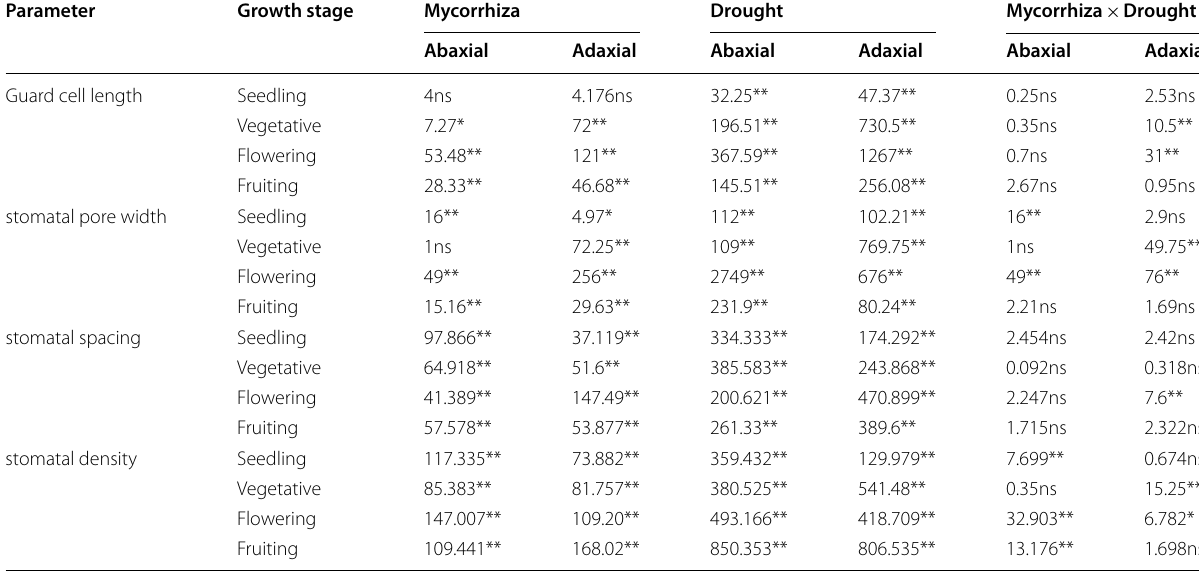
** P < 0.01; * P < 0.05; ns, non‑